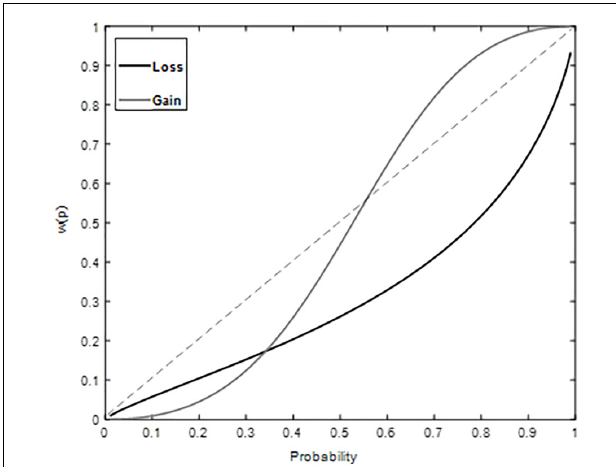
FIGURE 3 | Weighted Probability for gains and losses plotted against probability Study 2. Underweighting of small probabilities is observed for both gain and loss conditions.